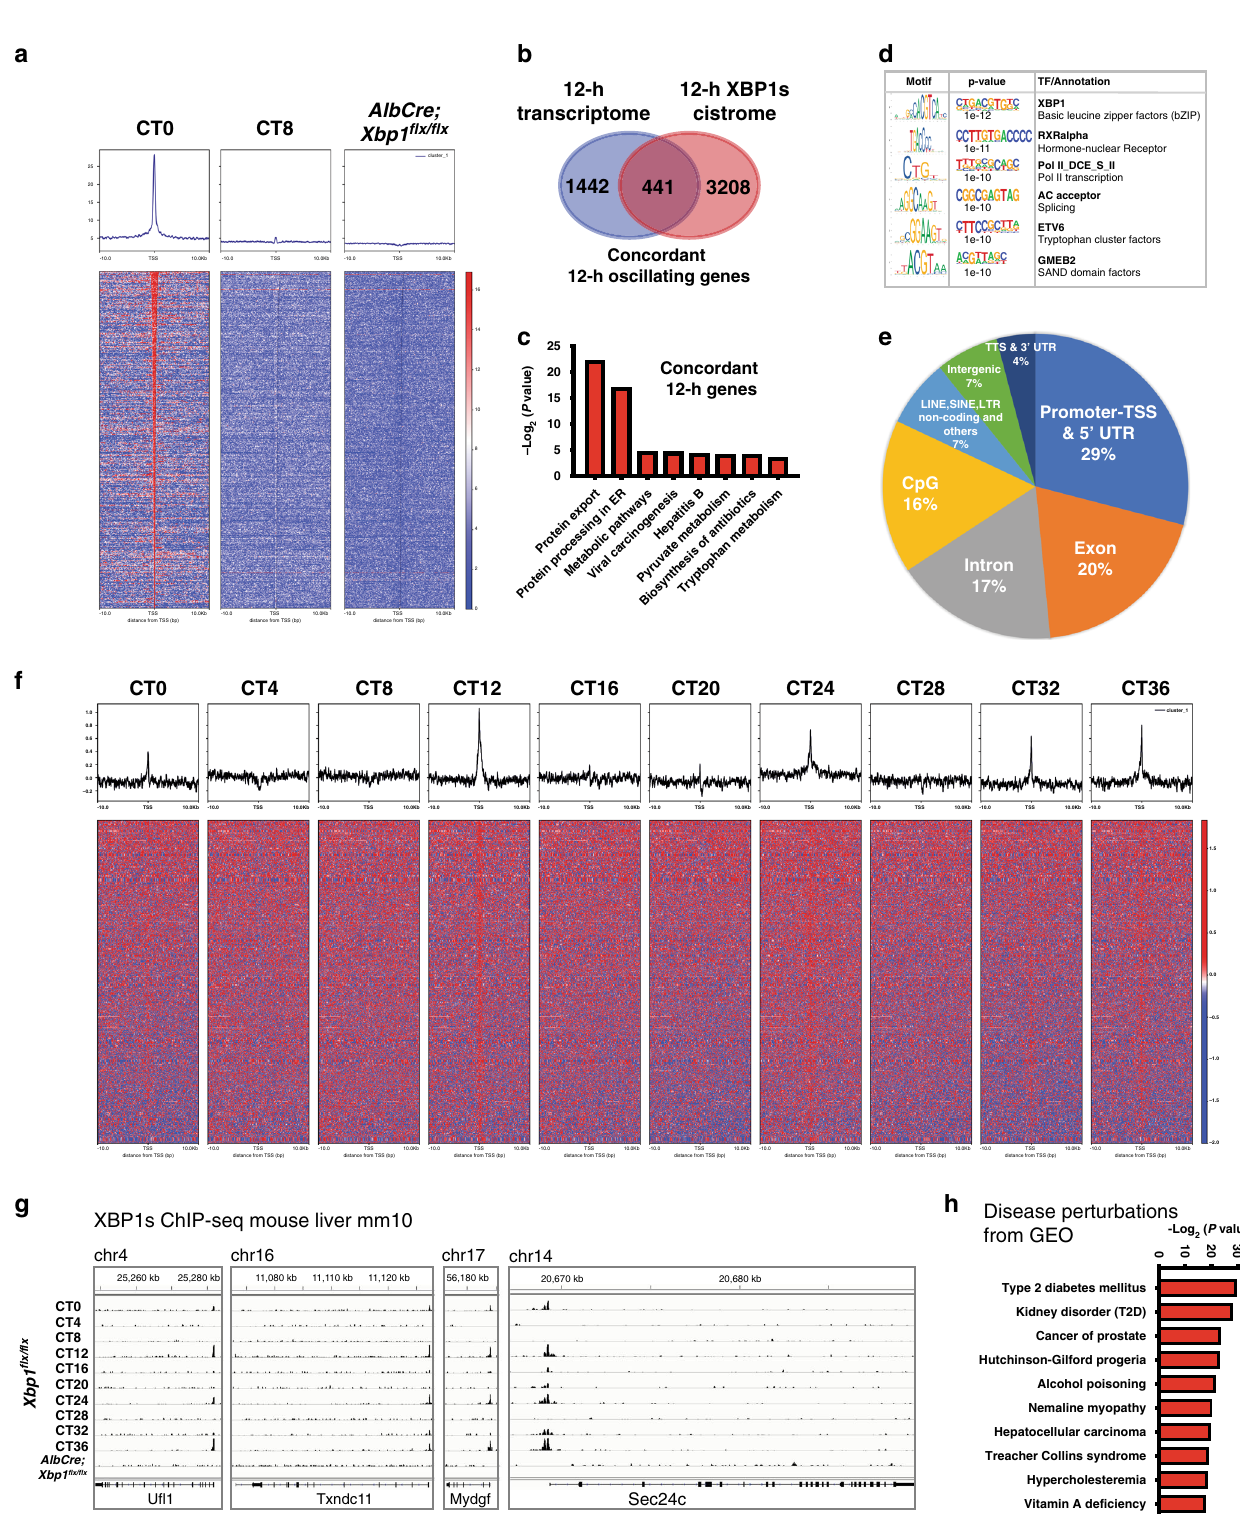
Fig. 3 XBP1s regulates the hepatic 12-h cistrome. a Binding pro fi les and heatmaps of XBP1s at the transcription start sites (TSSs) of 441 concordant 12-h oscillating genes in Xbp1 fl x/ fl x at CT0 (left) and CT8 (middle), and in the AlbCre;Xbp1 fl x/ fl x mice (right). The y axis represents the average signal in a 50-bp bin (normalized uniquely mapped reads). b Venn diagram of the 12-h transcriptome ( n = 1886) and the 12-h XBP1s cistrome ( n = 3649). Intersection: concordant 12-h oscillating genes ( n = 441). c Top-enriched KEGG pathways identi fi ed in the concordant 12-h oscillating genes. d Top-enriched transcriptional factor motifs identi fi ed from concordant 12-h oscillating genes. e The proportion of XBP1s cistrome in the concordant 12-h oscillating genes. f 12-h rhythmic XBP1s cistrome binding detected by ChIP-Seq were plotted as binding pro fi les and heatmaps for the concordant 12-h oscillating genes every 4 CT hours for 36 h in total. g Representative views of 12-h rhythmic XBP1s ChIP-Seq data at the U fl 1 , Txndc11 , Mydgf , and Sec24c gene loci. h Top-enriched disease perturbations identi fi ed from concordant 12-h oscillating